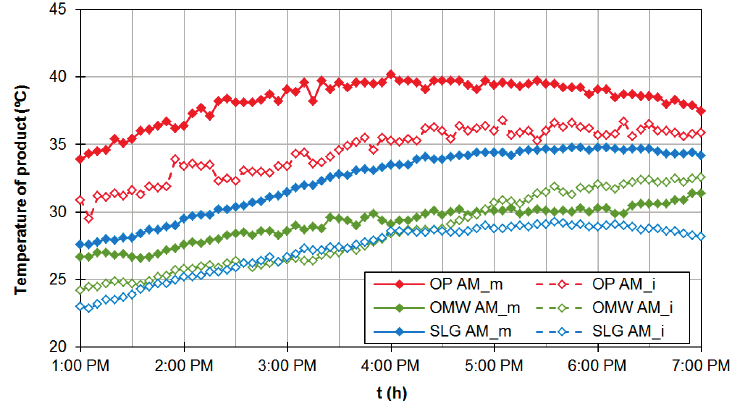
Figure 17. Product temperatures in AM (indirect and mixed